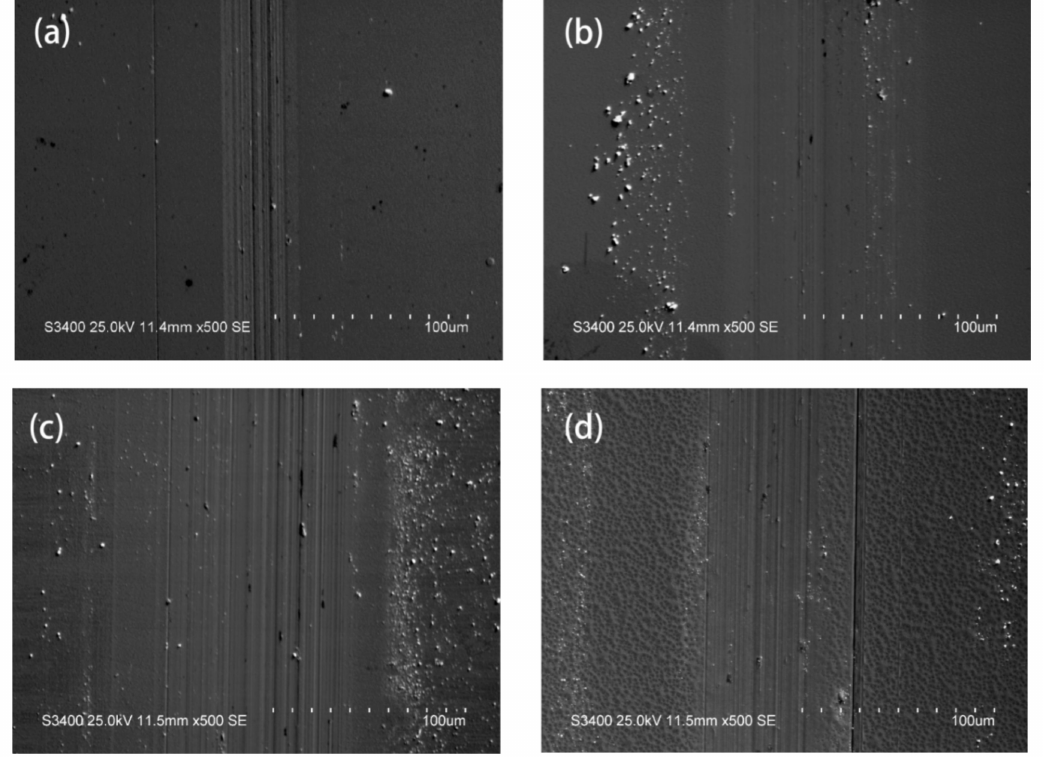
Figure 10. SEM pictures of several types of typical wear scars: ( a ) Sample B, ( b ) Sample E, ( c ) Sample H, and ( d ) Sample